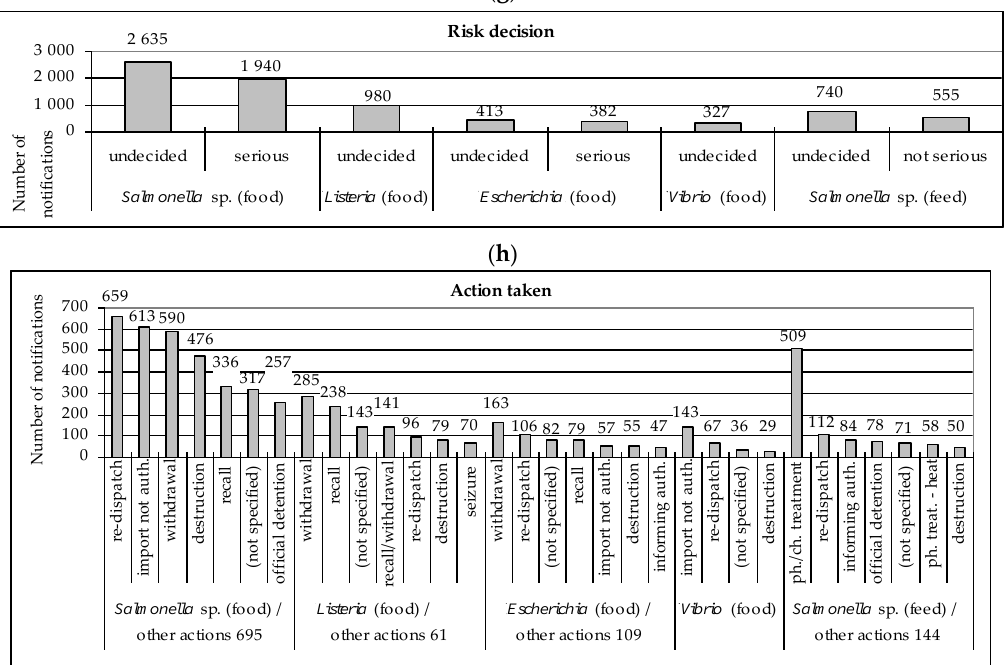
Figure 1. The numbers of RASFF notifications of pathogenic microorganisms in food and feed: ( a ) Year; ( b ) Product categories; ( c ) Notifying country; ( d ) Origin country; ( e ) Notification basis; ( f ) Notification type; ( g ) Distribution status; ( h ) Risk decision; ( i ) Action taken. Source: own study on the basis of [4].